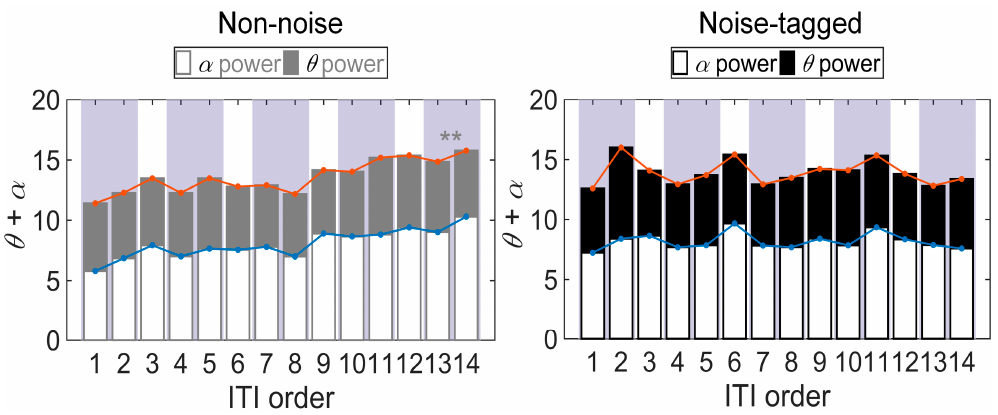
Figure 8. Stacked histograms showing the comparison of different fatigue indices (i.e., α , θ , and θ + α powers) between 14 consecutive non-task ITIs in both non-noise and noise-tagged conditions across participants. The grand-averaged mean values and SD of α , θ , and θ + α powers were calculated from 14 consecutive non-task ITIs of the same order in each run across twelve participants. The polyline in blue represented the time course of the grand-averaged α power along with the 14 ITIs within five stimulation sequences of multiple runs. The polyline in magenta represented the time course of the grand-averaged θ + α power. All statistics were assessed by one-way ANOVA, ** p < 0.01 between 14 consecutive ITIs.